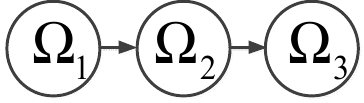
Figure 5. Attack zone migration process.